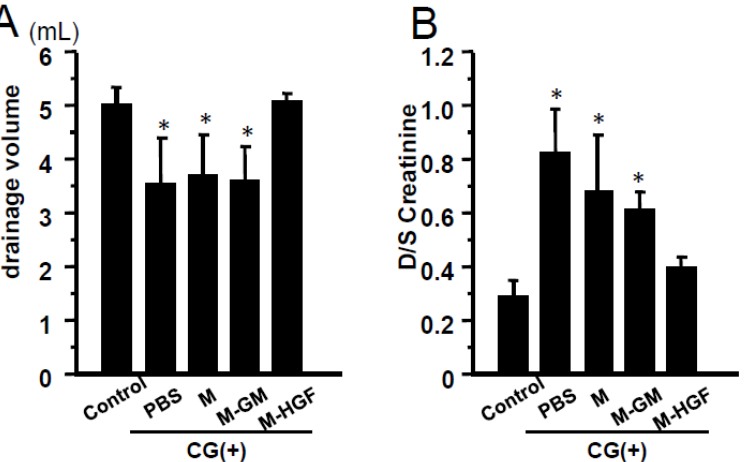
Figure 4. The results of peritoneal equilibration test. ( A ) Bar graph showing dialysate drainage fluid volume. The result exhibited lower drained volume in the PBS, M, and M-GM groups compared with the control group. Drained volume in the M-HGF group was maintained and was significantly increased compared to the PBS group. ( B ) The bar graph showing Dialysate (D)/Serum (S) ratio of creatinine. The result showed a higher D/S ratio of creatinine in the PBS, M, and M-GM groups compared with the control group. The D/S ratio of creatinine in the M-HGF group was the same as that in the control group and it was lower compared to the PBS group. * denotes a signi fi cant di ff erence against the control group at p < 0.05.